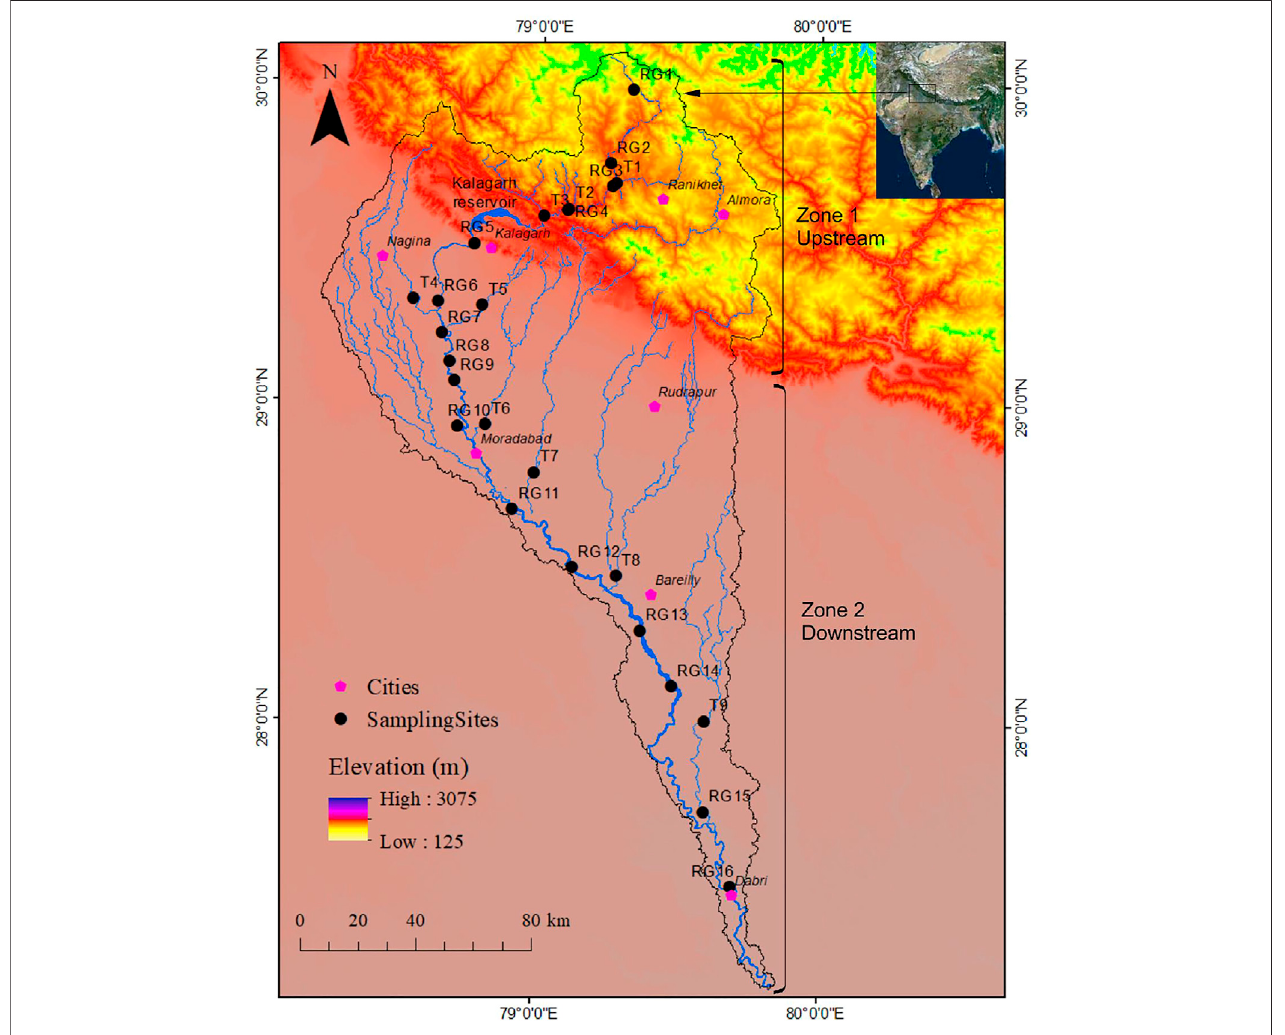
FIGURE 1 | Study area location with sampling sites (R1 – R16 represent samples collected from the Ramganga River, T1- Gagas, T2- Deota, T3-Mandal, T4- Kho, T5- Phika, T6- Dhela, T7- Kosi, T8- Bhakra, and T9- Baigul).